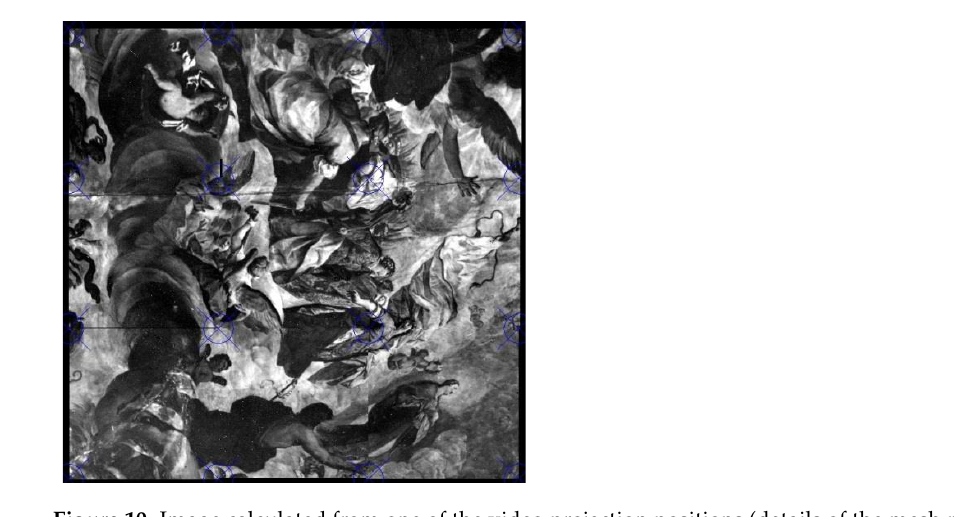
Figure 9. The 4 × 4 mesh projected on the model. Expanded mesh detail.